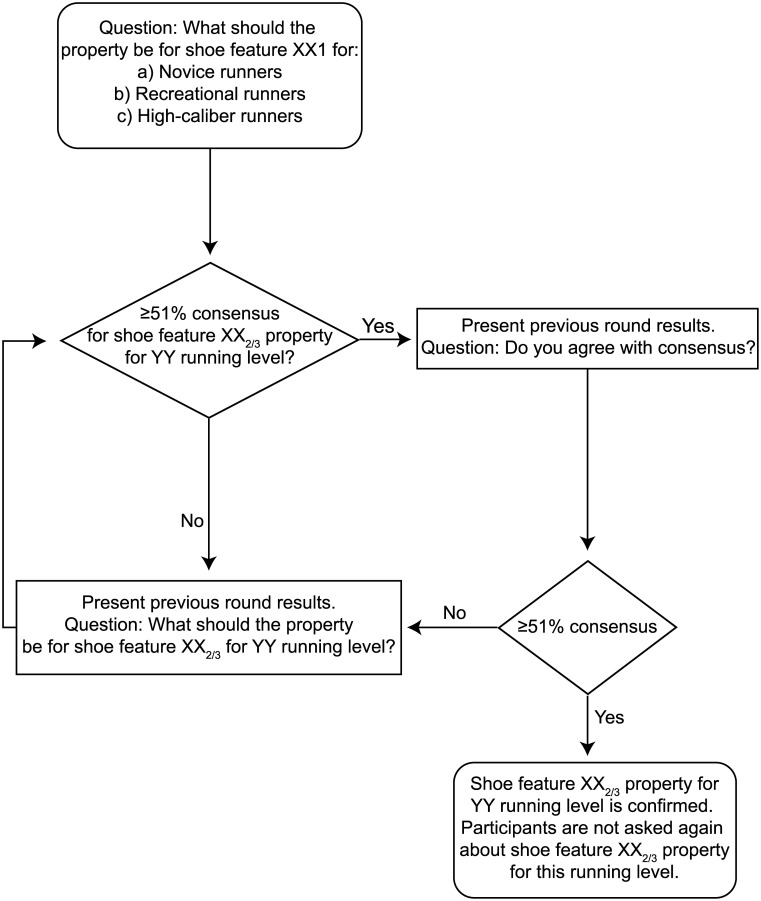
Flowchart describing the consensus and verifying consensus process for different shoe feature properties (XX) for each running level (YY).The participants were asked to provide feedback for the recommended properties for all runner levels on all 20 shoe features (XX1). In the second- and third-rounds, the participants were asked to provide feedback for the recommended properties for all runner levels on the important shoe features and any additional shoe features the participants recommended (XX2/3).